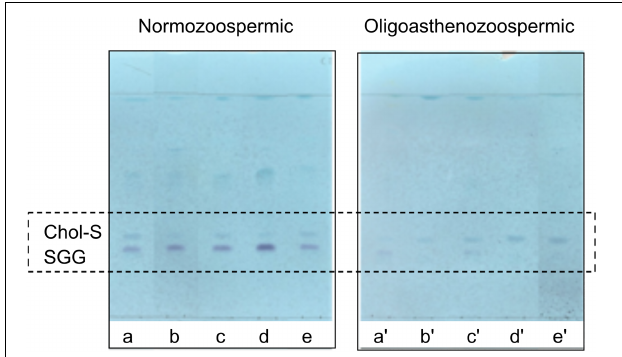
FIGURE 5 | Comparison of TLC sulfolipid profiles of semen of normozoospermic subjects and oligoasthenozoospermic patients. Total lipids were extracted from semen samples of normozoospermic (a, b, c, d, e) and oligoasthenozoospermic (a (cid:48) , b (cid:48) , c (cid:48) , d (cid:48) , e (cid:48) ) subjects and then eluted with the same solvent as in TLC showed in Figure 1 . Azure A reagent was used to stain sulfur-containing lipids only. Lipid bands assigned to cholesterol sulfate (Chol-S) and seminolipid (SGG) are indicated by their